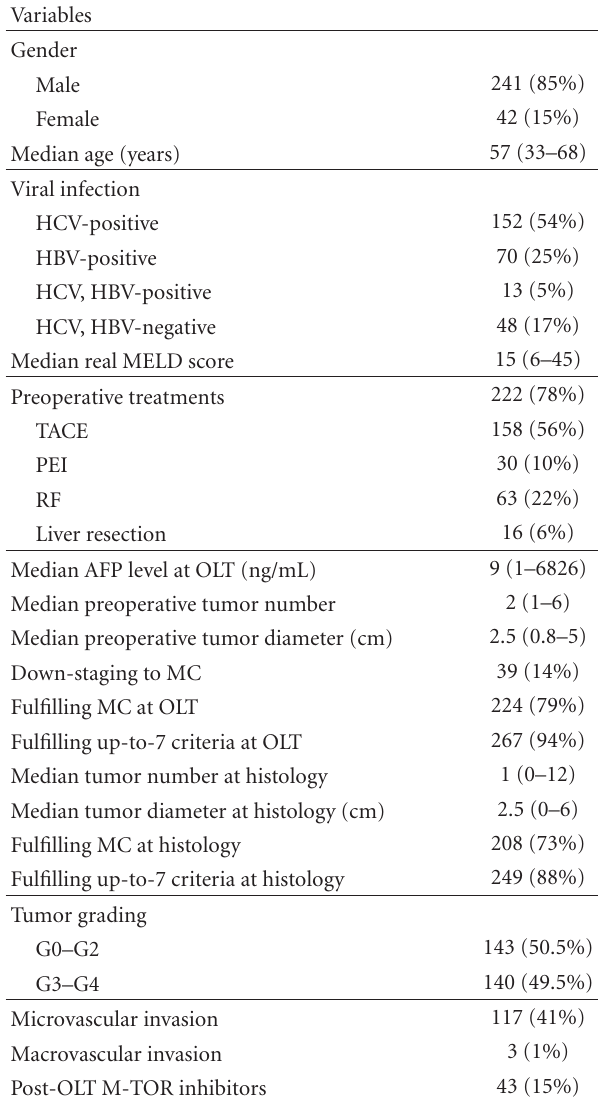
Table 1: Demographic, clinical, and pathological parameters of 283 patients with HCC receiving OLT at the Bologna Center between 1997 and